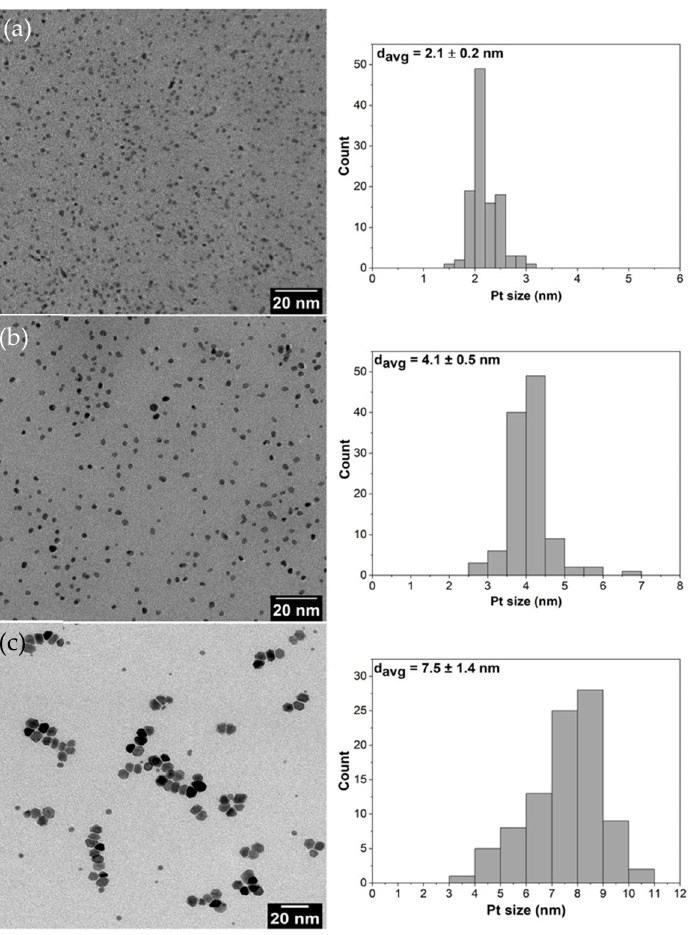
Figure 1. TEM images together with their particle size distributions of Pt nanoparticles with average sizes of: ( a ) 2 nm; ( b ) 4 nm; and ( c ) 8 nm.